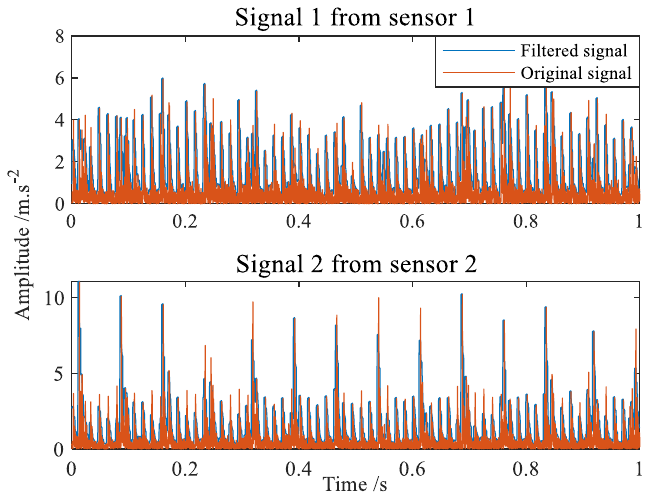
Figure 14. Signal contrast diagram before and after